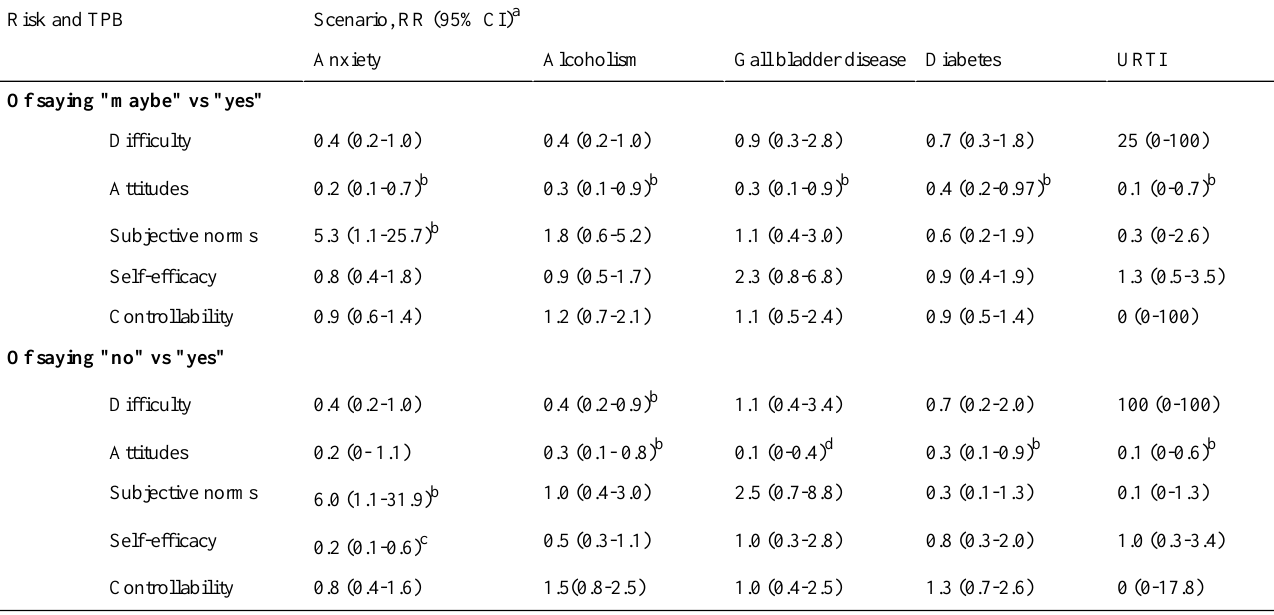
Table 7. The relative risk (RR) ratio of difficulty of diagnosis and TPB scores associated with GPs’ intention to continue the consultation within each scenario